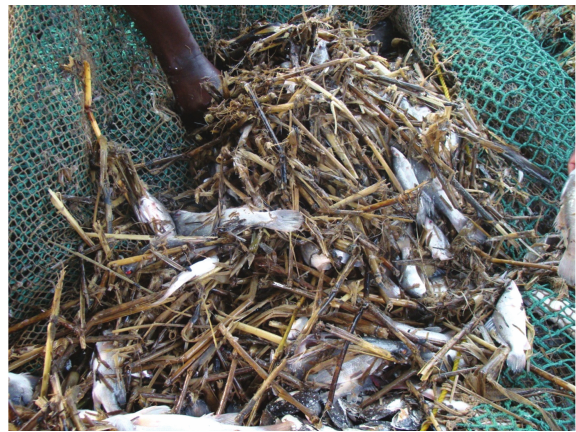
Figure 7: Fragments of the hippograss at the bottom of the lake as obtained from the bottom trawls of the sampled